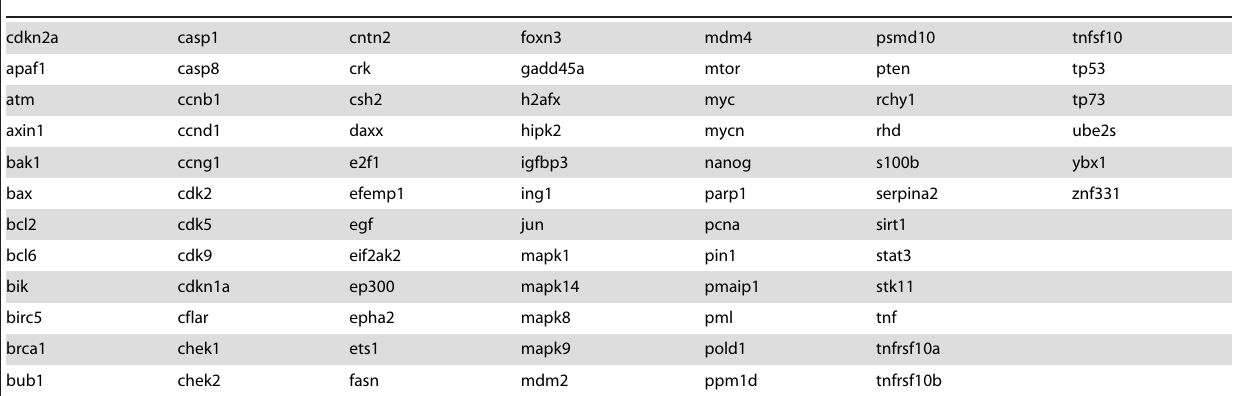
Table 3. Genes from KEGG P53